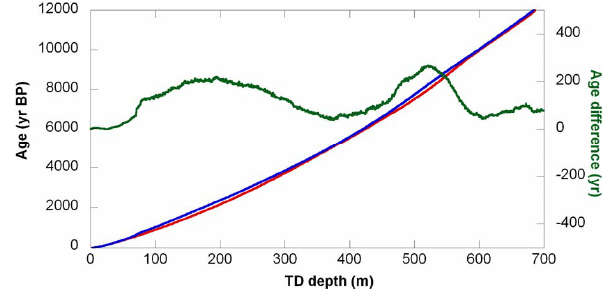
2 Figure 8. Age-to-depth plot for the TD ice core. The blue curve represents the TALDICE-1 3 Fig. 8. Age-to-depth plot for the TD ice core. The blue curve repre- modelled age scale and the red curve represents the new age-to-depth relation built in this 4 sents the TALDICE-1 modelled age scale and the red curve repre- work. Green curve represents the age offset between the two age-scales. 5 sents the new age-to-depth relation built in this work. Green curve represents the age offset between the two